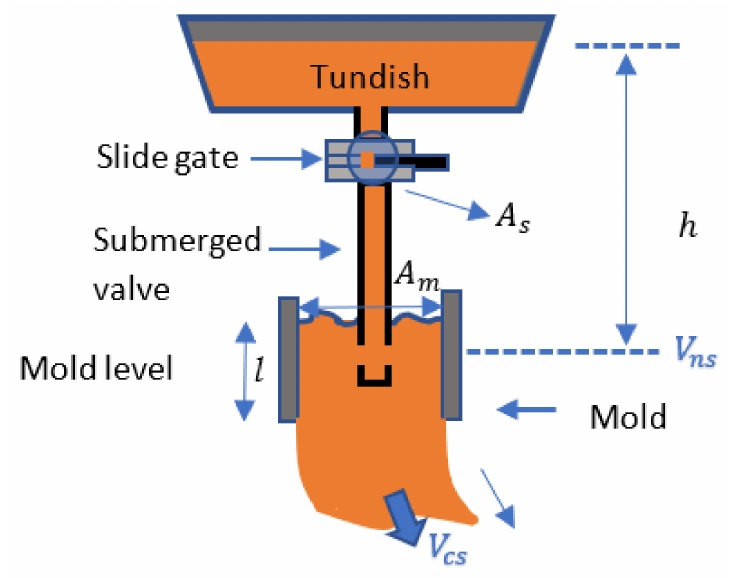
Figure 2. Steel flow from tundish to